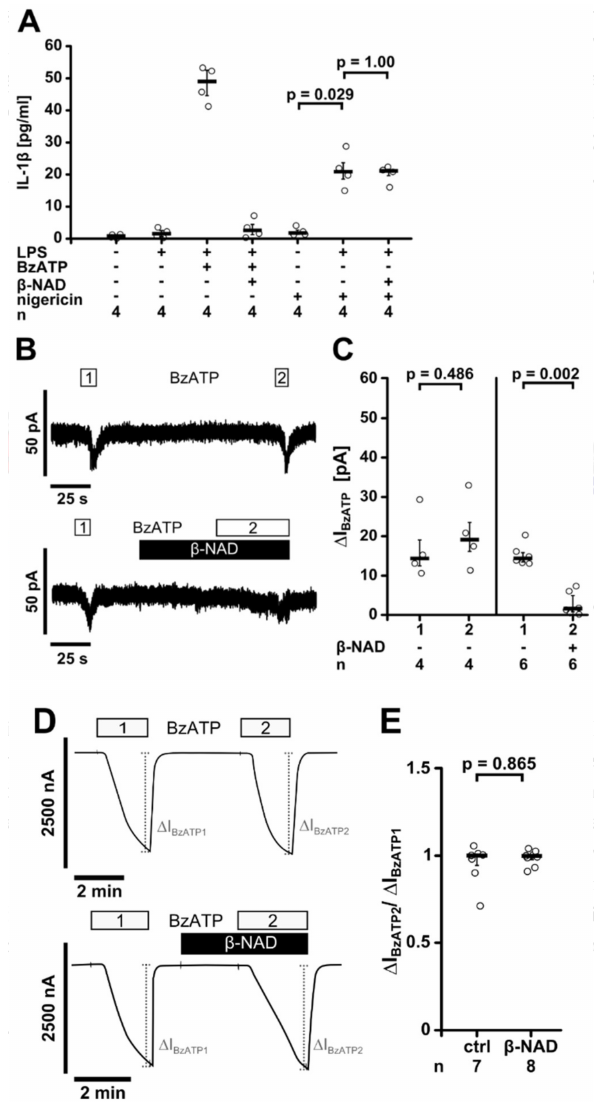
Figure 7. β -NAD inhibits the ion channel function of ATP receptor P2X7. ( A ) Human monocytic U937 cells were primed with LPS (1 µ g/mL, 5 h) and activated with 2 (cid:48) (3 (cid:48) )- O -(4-benzoylbenzoyl)adenosine-5 (cid:48) -triphosphate (BzATP; 100 µ M, 30 min) or nigericin (50 µ M) in combination with apyrase (0.5 U/mL). β -NAD was used at a concentration of 1 mM. The concentration of IL-1 β in the cell culture supernatant was measured by ELISA; ( B , C ) BzATP-induced ion currents were detected by whole-cell patch-clamp measurements in LPS-primed U937 cells; ( B ) Repetitive current changes provoked by two (1, 2) consecutive BzATP (100 µ M) applications. Application of β -NAD (1 mM) alone did not provoke ion currents but fully inhibited the response to BzATP; ( C ) Graphical presentation of the two consecutive BzATP-induced ion current changes (1, 2, ∆ I BzATP ) ( D , E ) Two-electrode voltage-clamp (TEVC) measurements were performed on Xenopus laevis oocytes that heterologously expressed human P2X7 receptors; ( D ) Representative current curves. In control experiments (ctrl; upper panel) BzATP (10 µ M; 2 min) induced repetitive stimulations of the transmembrane ion current ( ∆ I BzATP1 and ∆ I BzATP2 ). Application of β -NAD (1 mM) had no impact on ∆ I M and did not impair the consecutive response to BzATP (lower panel); ( E ) Normalized values ( ∆ I BzATP2 / ∆ I BzATP1 ) from experiments as shown in ( D ). Data are presented as individual data points, bar represents median, whiskers encompass the 25th to 75th percentile ( A , C , E ). Experimental groups were compared by or Kruskal-Wallis followed by Mann-Whitney rank sum test ( A ) or Wilcoxon signed-rank test ( C , E